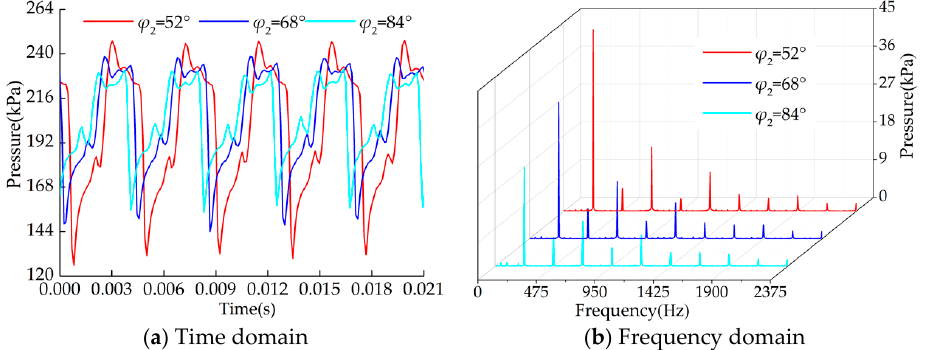
Figure 15. Frequency response curves of pressure inside the impeller with different wrap angles of